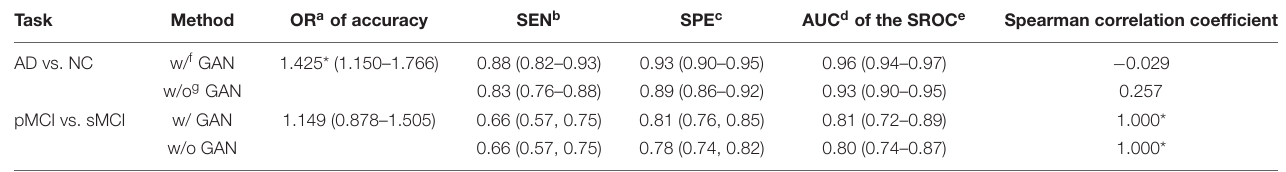
TABLE 2 | The results of meta-analyses of the diagnosis of AD.